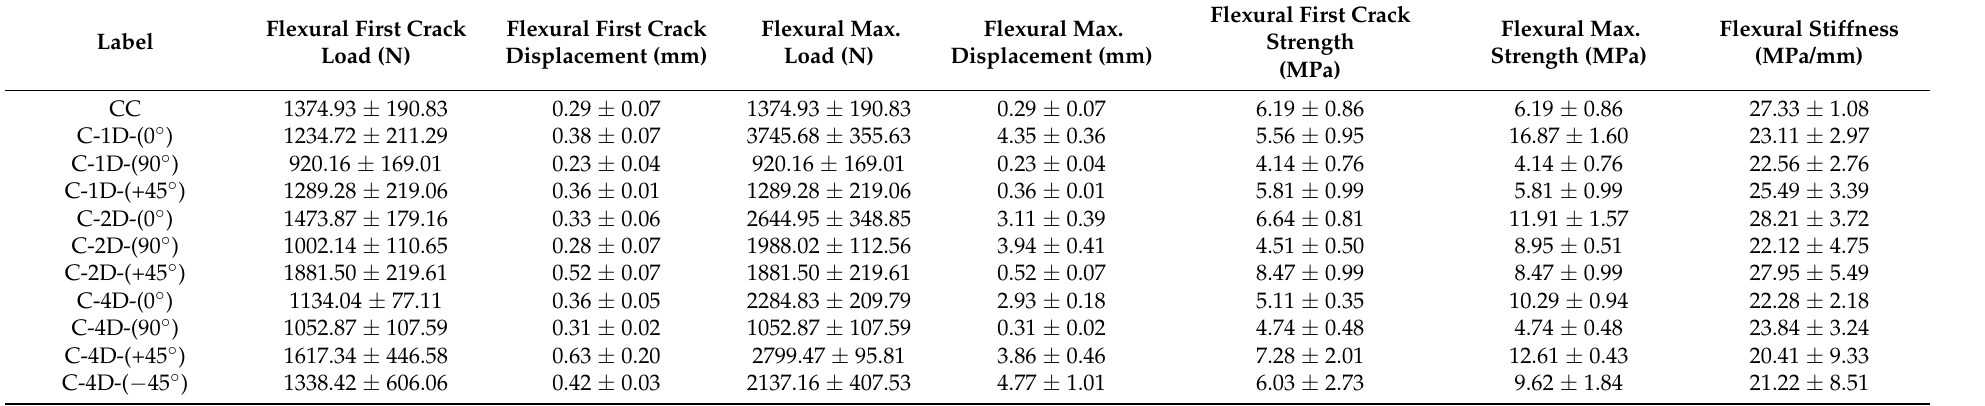
Table 4. Average flexural test results on the multiaxis 3D carbon fiber concrete